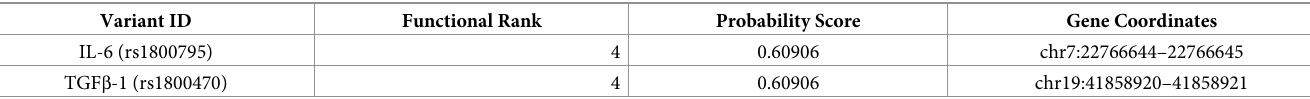
Table 2. RegulomeDB analysis of IL-6 (rs1800796) and TGF- β 1 (rs1800470) variants. Variant